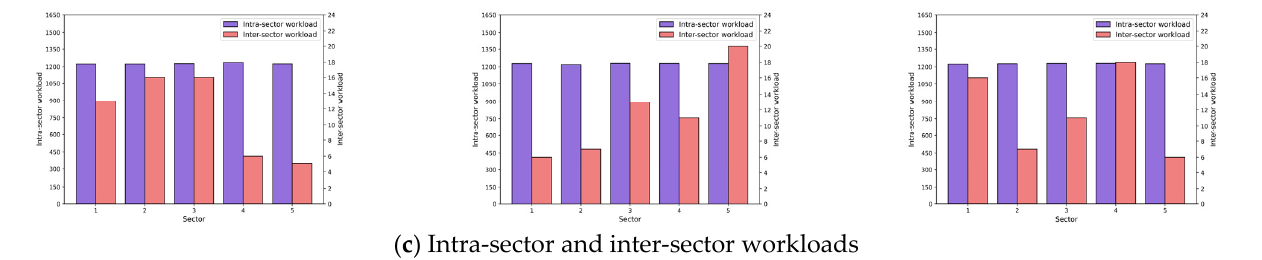
Figure 9. Airspace sectorization results for area two (i.e., solutions of [0.0034, 56], [0.0032, 57], and [0.0019, 58] in Runs 1, 5, and 3, respectively). ( a ) Results in 3D view; ( b ) results in 2D view; ( c ) intra-sector and inter-sector workloads for each solution.